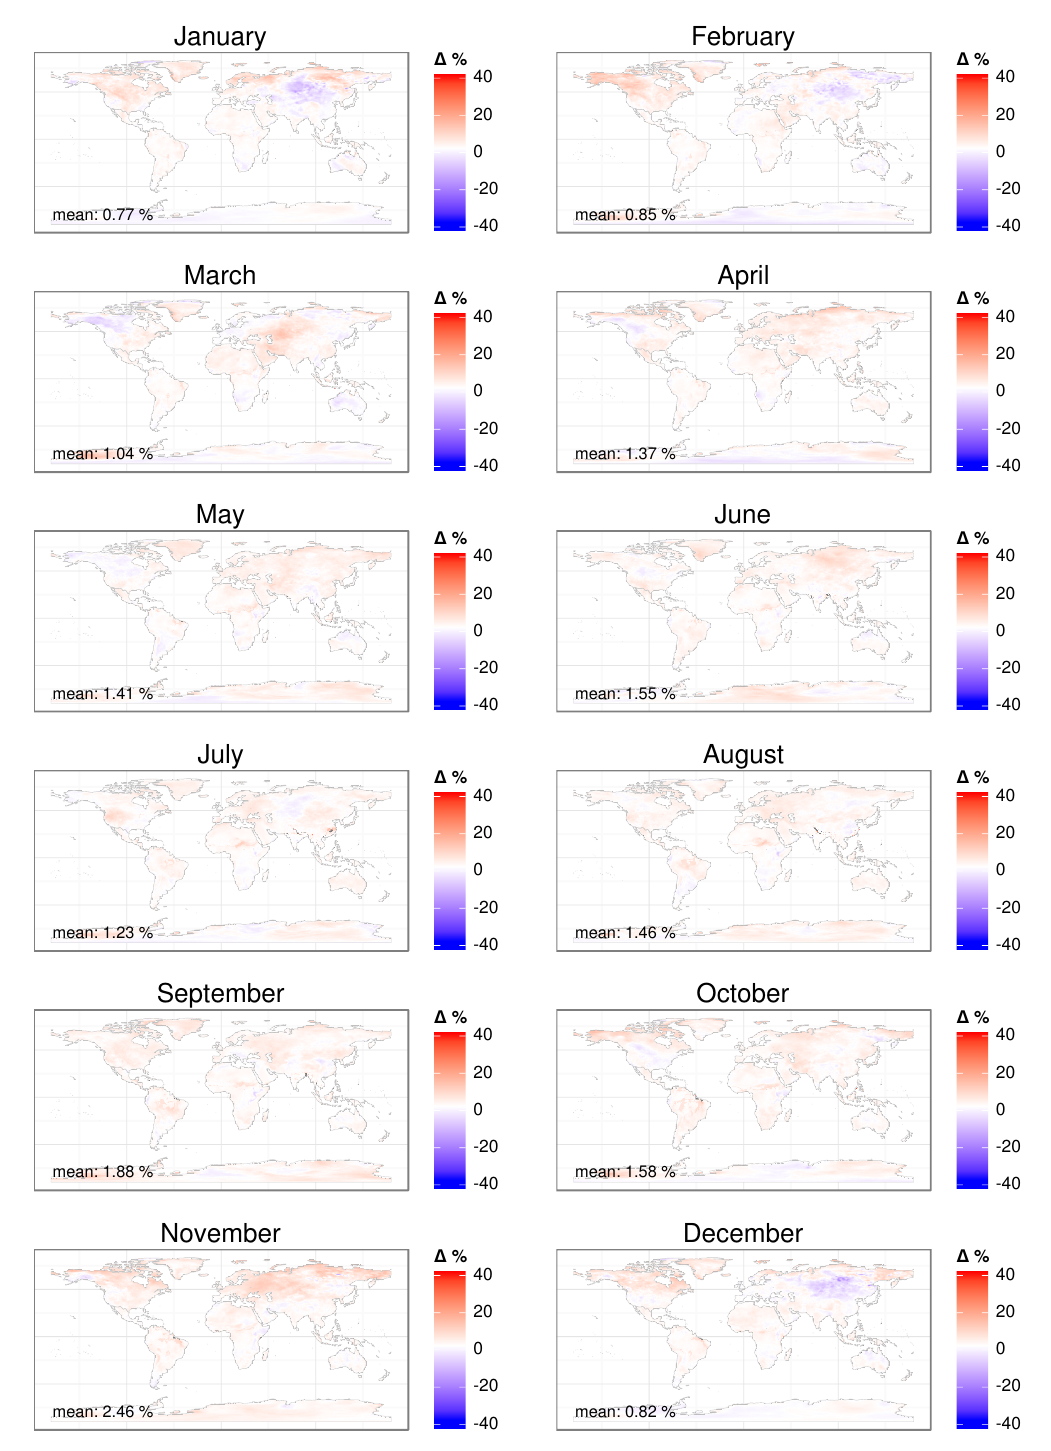
Figure 4. Change in the probability that the maximum heat index will exceed the threshold for “extreme danger” for a given day in each month in 2000–2013 compared to 1979–1999 (National Weather Service, 2014b). Continents are added for orientation (South, 2011; Bivand and Rundel,